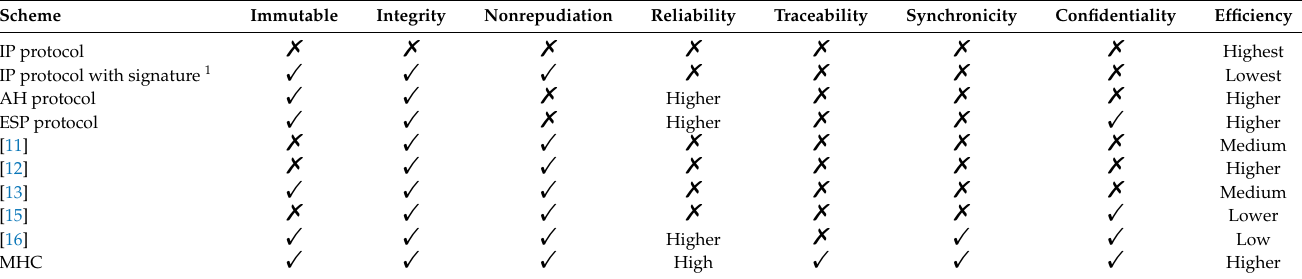
Table 5. Comparison of security properties of different schemes